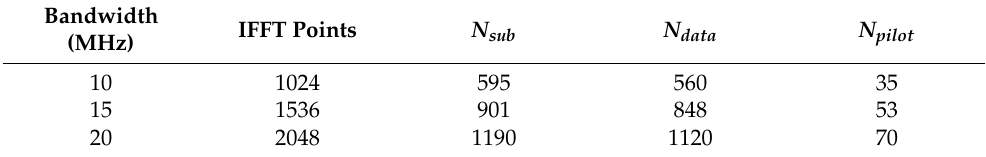
Table 1. Some simulation parameters.